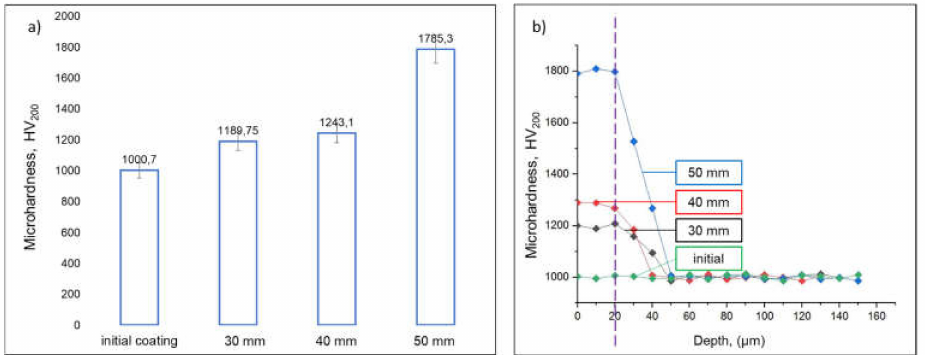
Figure 6. Surface microhardness ( a ) and the cross-section of detonation coatings based on Ti–Si–C ( b ) before and after pulsed-plasma treatment, depending on the distance from the